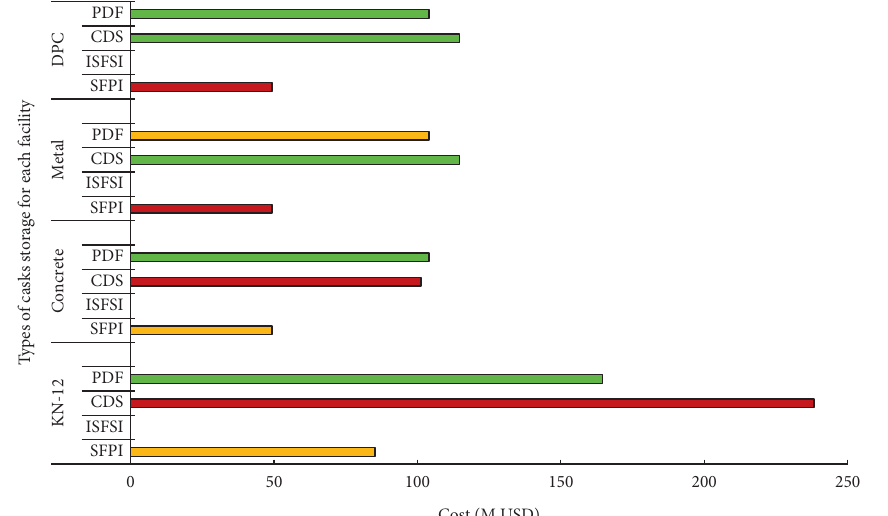
Figure 11: Breakdown of costs for each facility storage utilizing different types of cask storage.